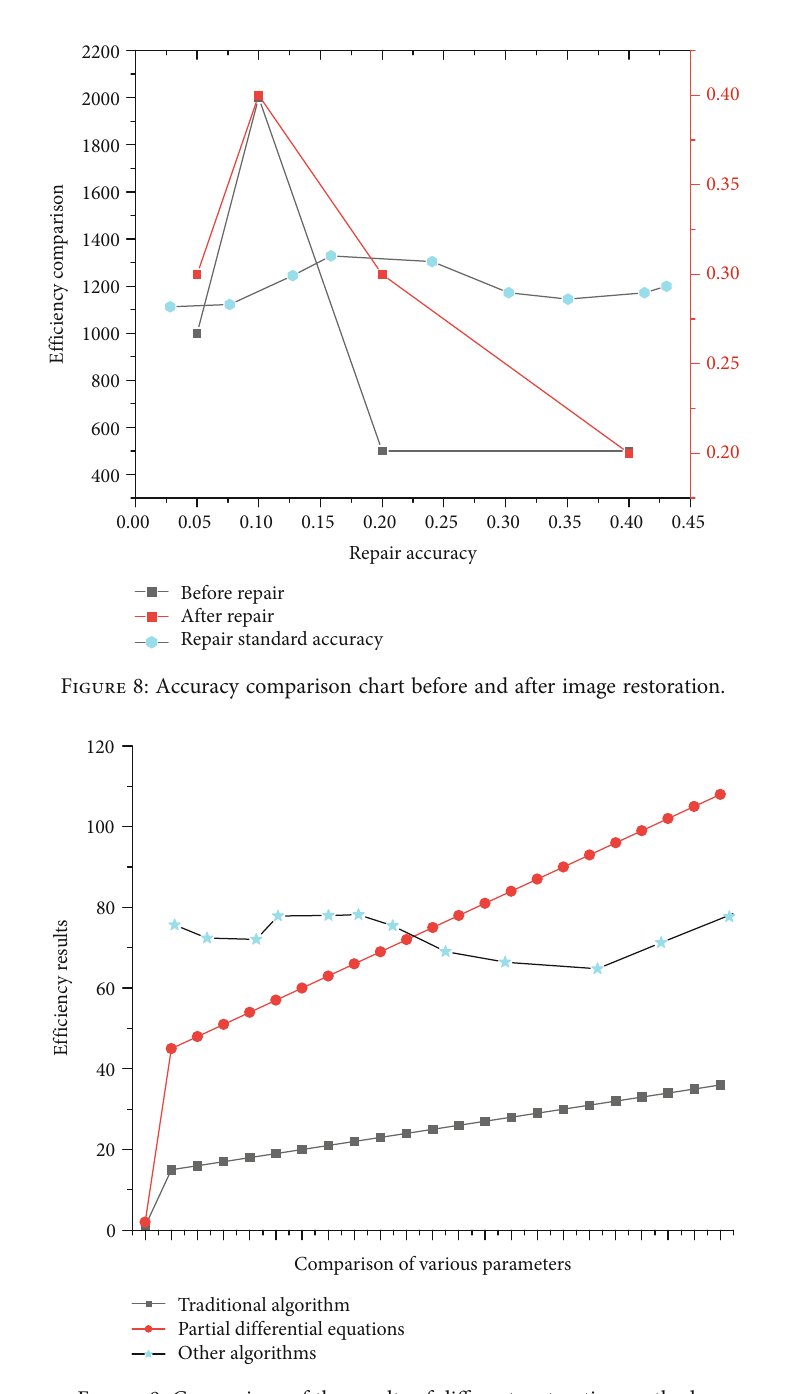
Figure 9: Comparison of the results of di ff erent restoration